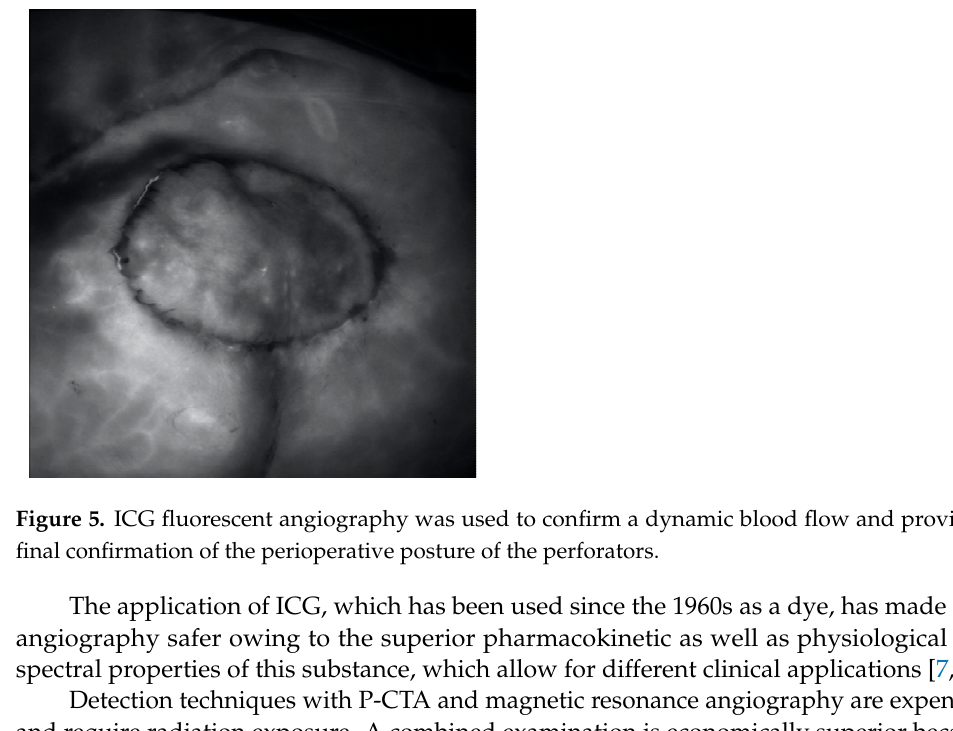
Figure 5. ICG fluorescent angiography was used to confirm a dynamic blood flow and provide a final confirmation of the perioperative posture of the perforators.